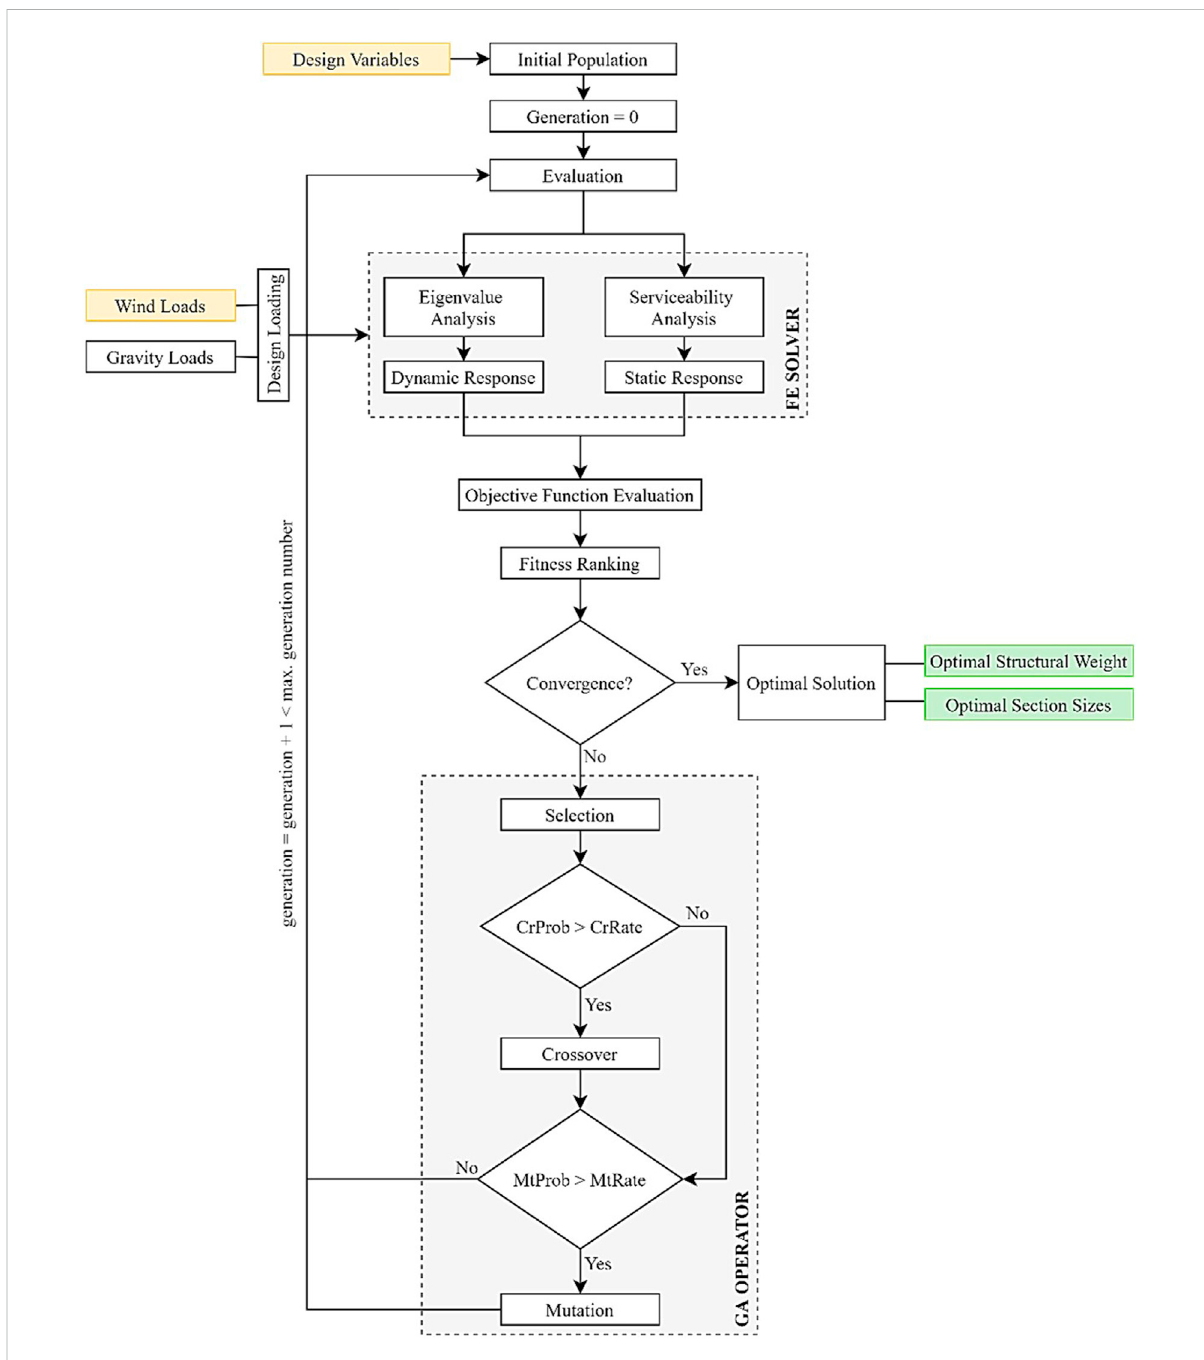
FIGURE 2 Genetic Algorithm optimization